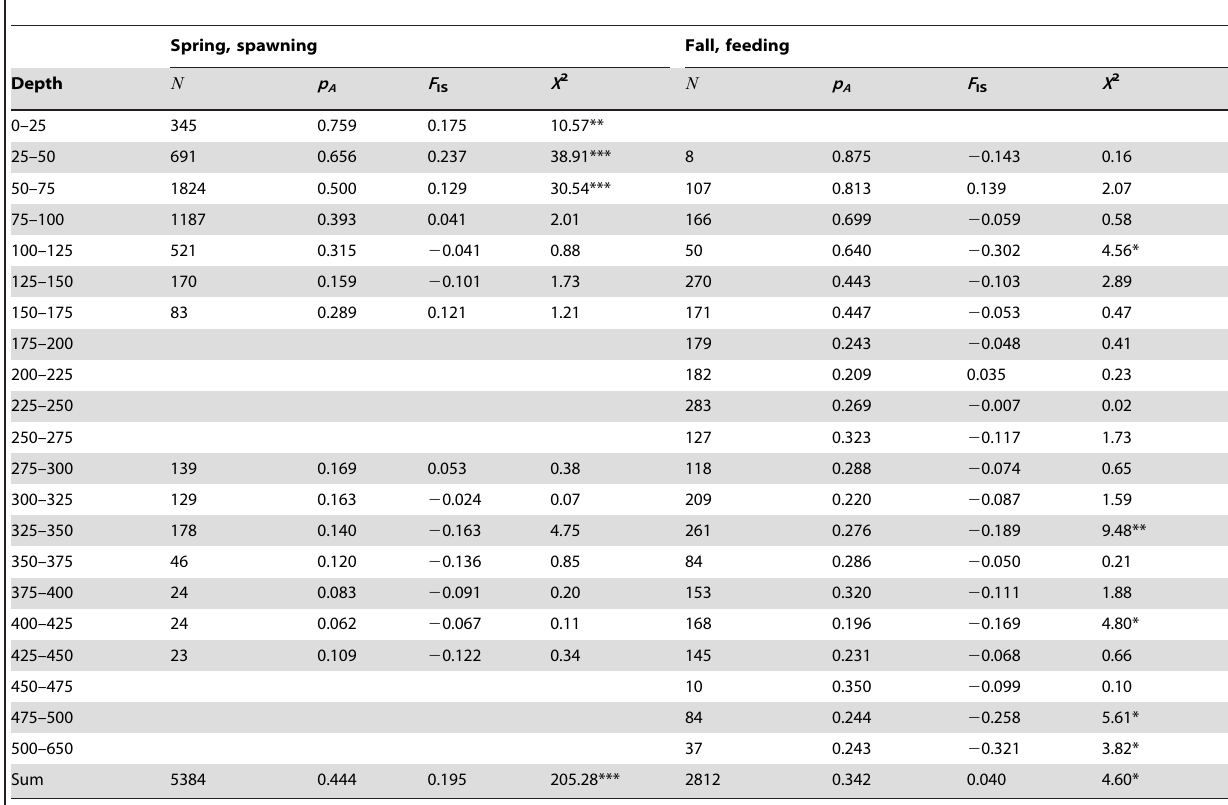
Table 1. Pan I allele frequencies and Hardy-Weinberg deviations by 25 m depth classes among Atlantic cod.